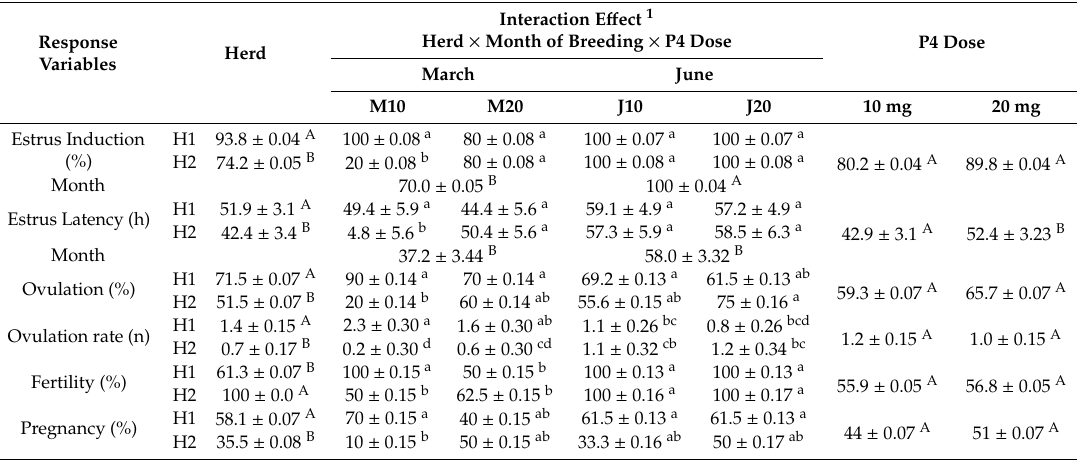
Table 2. Least square means for estrus induction, estrus latency, ovulation, ovulation rate, fertility, pregnancy, and some first–order interactions in adult–anestrous crossbred (Alpine–Saanen–Nubian x Criollo) goats exposed to an ultra–short P4 & eCG based estrus induction protocol and bred either in March or June, using two P4 doses (10 or 20 mg) in two commercial herds in Mexico (25 ◦ N). Response Variables